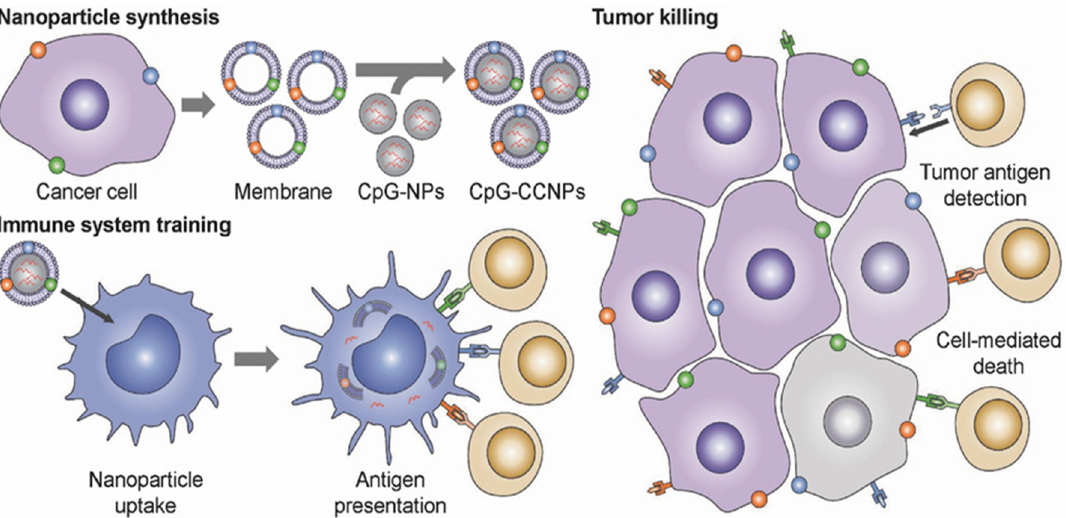
Figure 2. Schematic diagram of TCMVs-based CpG-anti-tumor vaccines. Use of cancer cell mem- branes carrying tumor-specific antigens to wrap CpG-loaded nanoparticles to generate nanoparticle tumor vaccines. The tumor-specific antigens on the surface of TCMVs promote uptake and presen- tation by antigen-presenting cells, activating multiple specific T cells that act to monitor and kill tumor cells. Reproduced with permission [81]. Copyright 2017, Wiley-VCH.